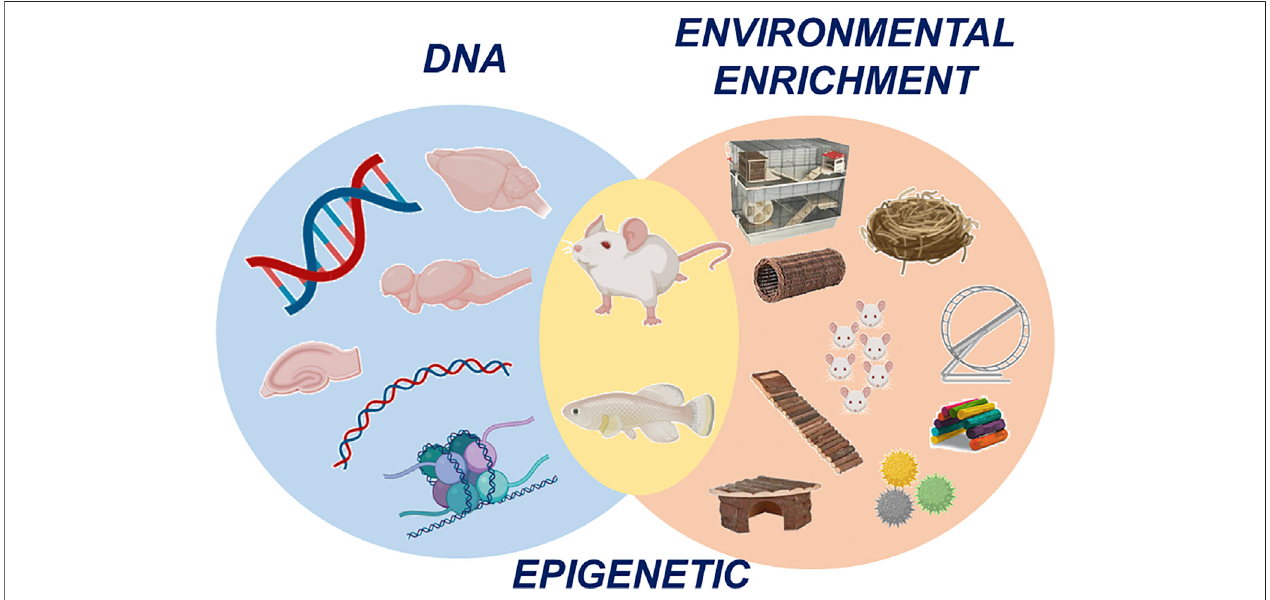
FIGURE 1 | The diagram displays the interaction between environmental enrichment and epigenetic mechanisms. The present research topic addresses the question of how basic experimental research in different species can contribute to the development of therapeutic applications of enriched environments (Figure elaborated with